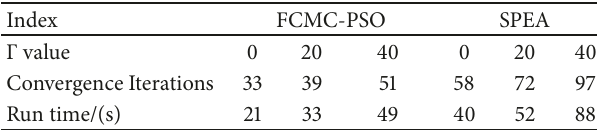
Table 14: Pareto optimal solutions for distribution center a when Γ = 0, Γ = 10 and Γ = 20.